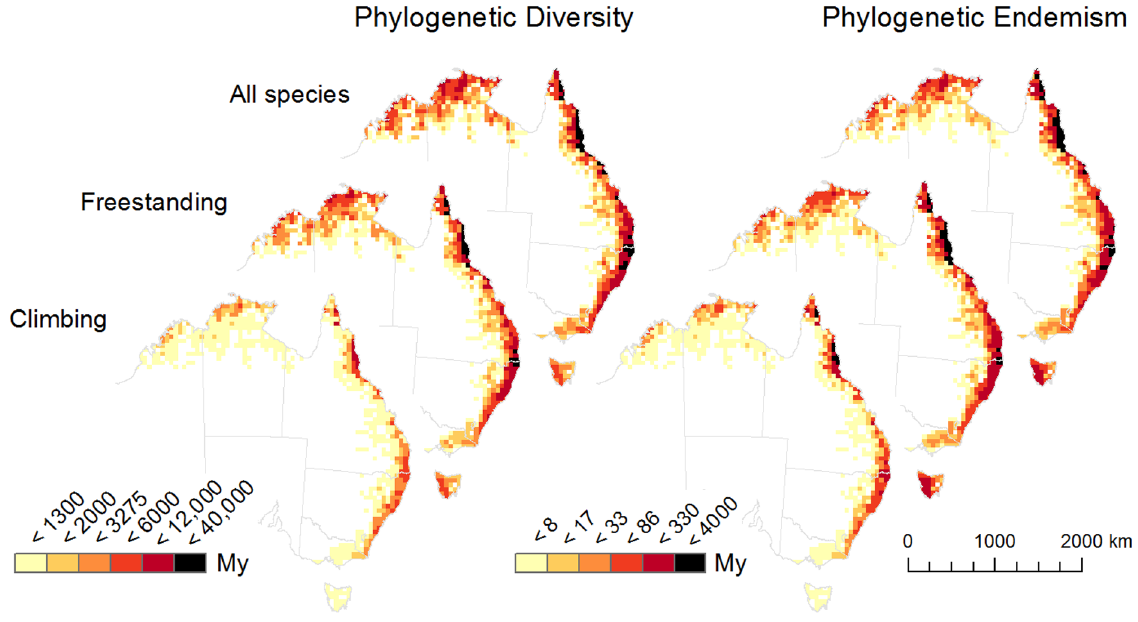
Figure 2. Phylogenetic diversity patterns. Phylogenetic Diversity (PD) and Phylogenetic Endemism (PE) values for 50 6 50 km grid cells for all woody plants combined, and for two growth forms representing freestanding (trees and shrubs), and climbing (vines) plants. For clarity of presentation cells are clipped to the coastline and off-shore islands are not displayed. Darker colours (red to black) and higher values reflect greater concentrations of evolutionary diversity, particularly for PE. PD is highly correlated with species richness so can also be read as a ‘heat map’ for